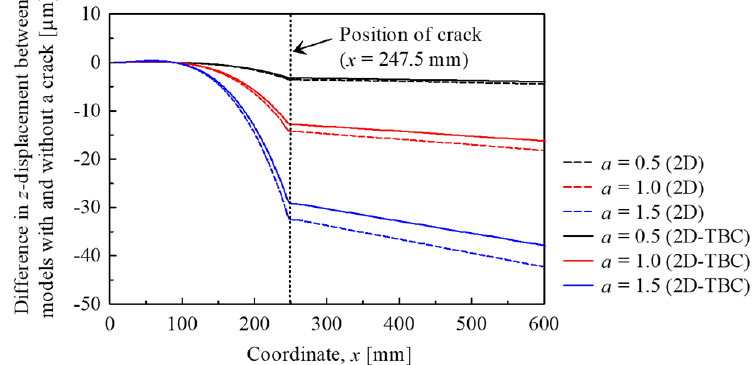
Figure 10. The difference in the z -displacement between the models with and without a crack of Model 2D-TBC.